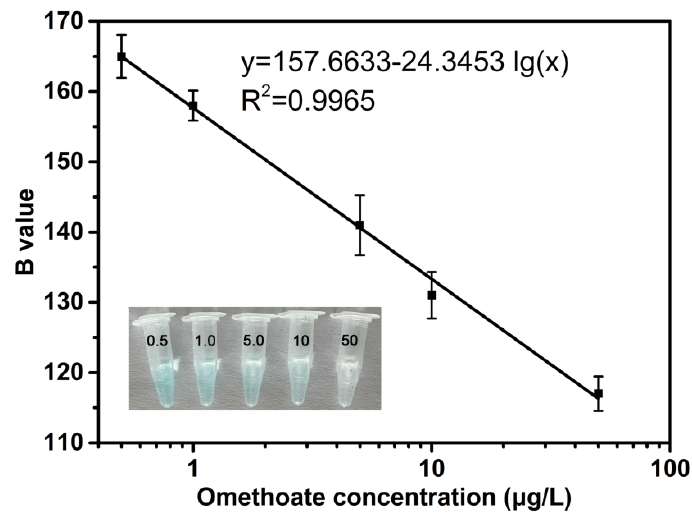
Figure 2. The optimization of the working parameters of the colorimetric sensor. ( A ) Added amount of anti-omethoate antibody, ( B ) added amount of coating antigen, ( C ) added amount of signal probe, and ( D ) incubation time.